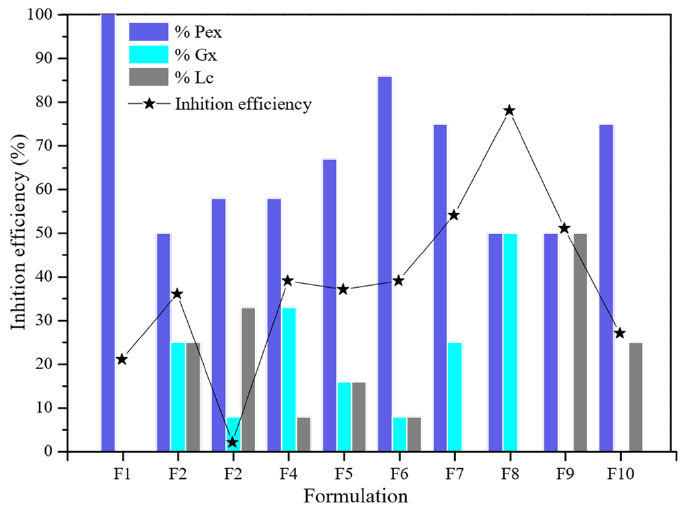
Figure 3. Corrosion inhibition efficiency graph for each of the extracted pectin (Pex), xanthan gum (Gx), and lechero plant (Lc) mixture variants in the experimental design.